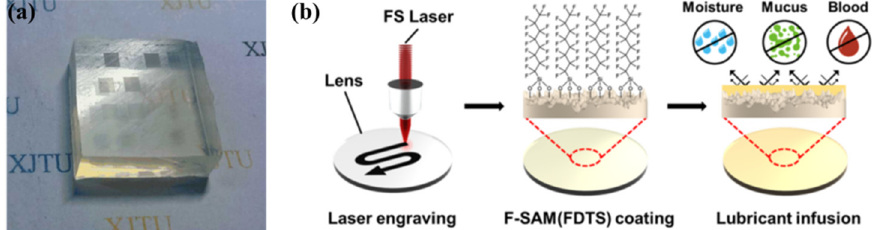
Figure 9. Process of preparing non-metallic superhydrophobic surface: ( a ) superhydrophobic sur- faces of PDMS [106], ( b ) Process of preparing superhydrophobic surfaces for lenses [107].